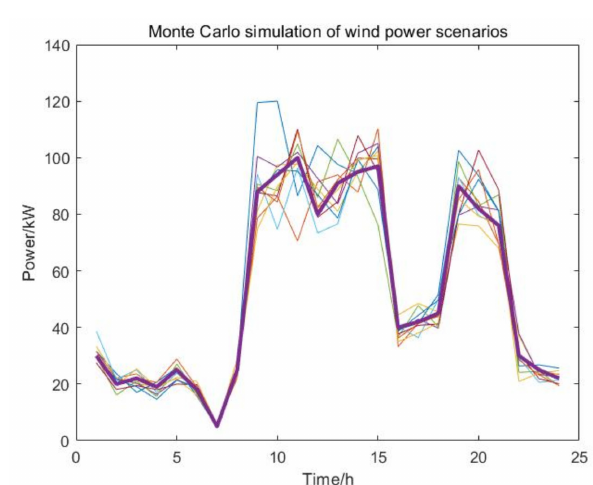
Figure A1. Typical wind power scenarios.